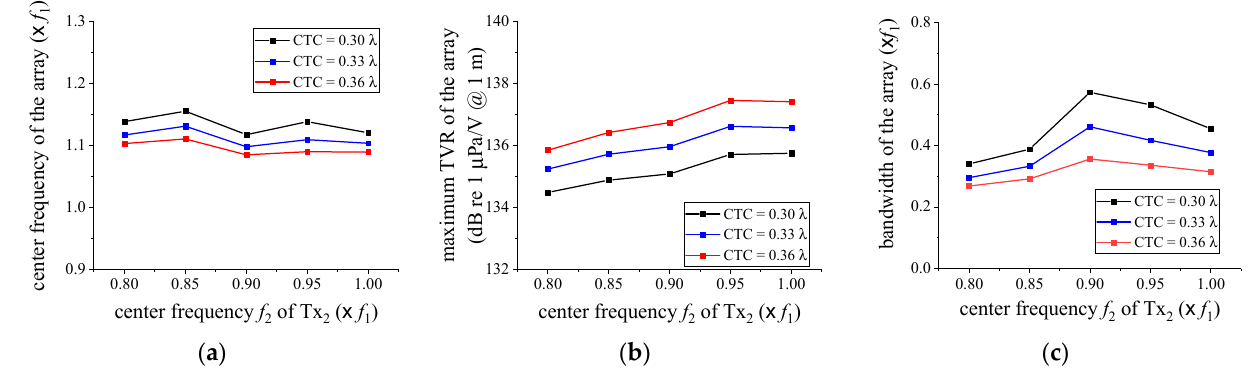
Figure 6. Variations of the acoustic characteristics of the cymbal array in relation to f 2 : ( a ) center frequency; ( b ) maximum TVR level; ( c ) bandwidth.